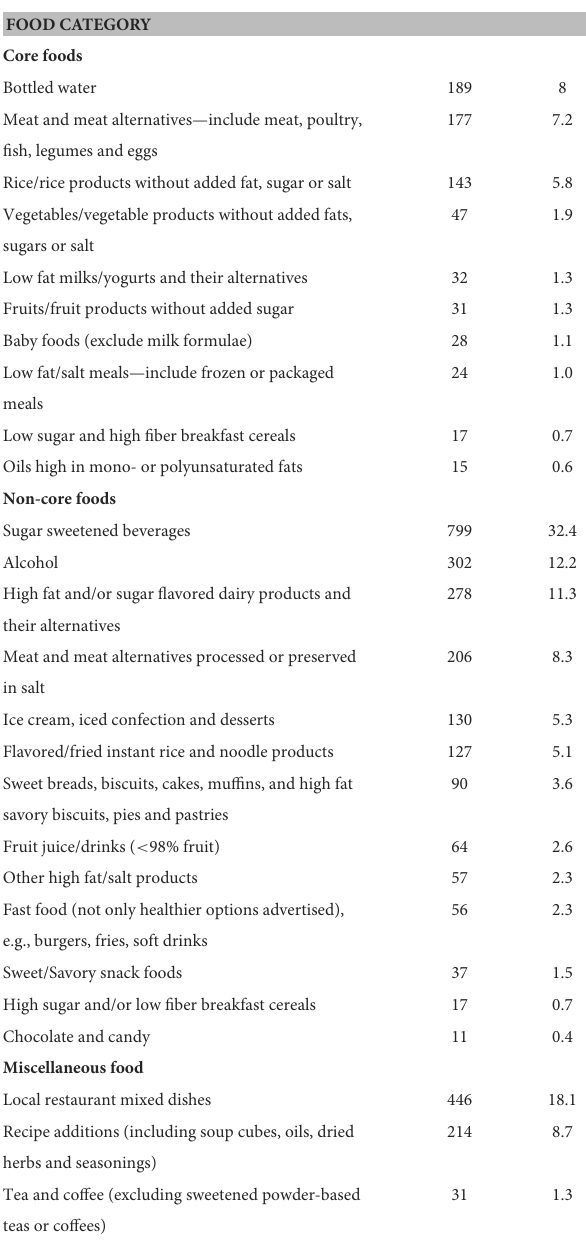
TABLE 3 Food categories and distribution by proportion of food advertisements in/around schools in Greater Accra.